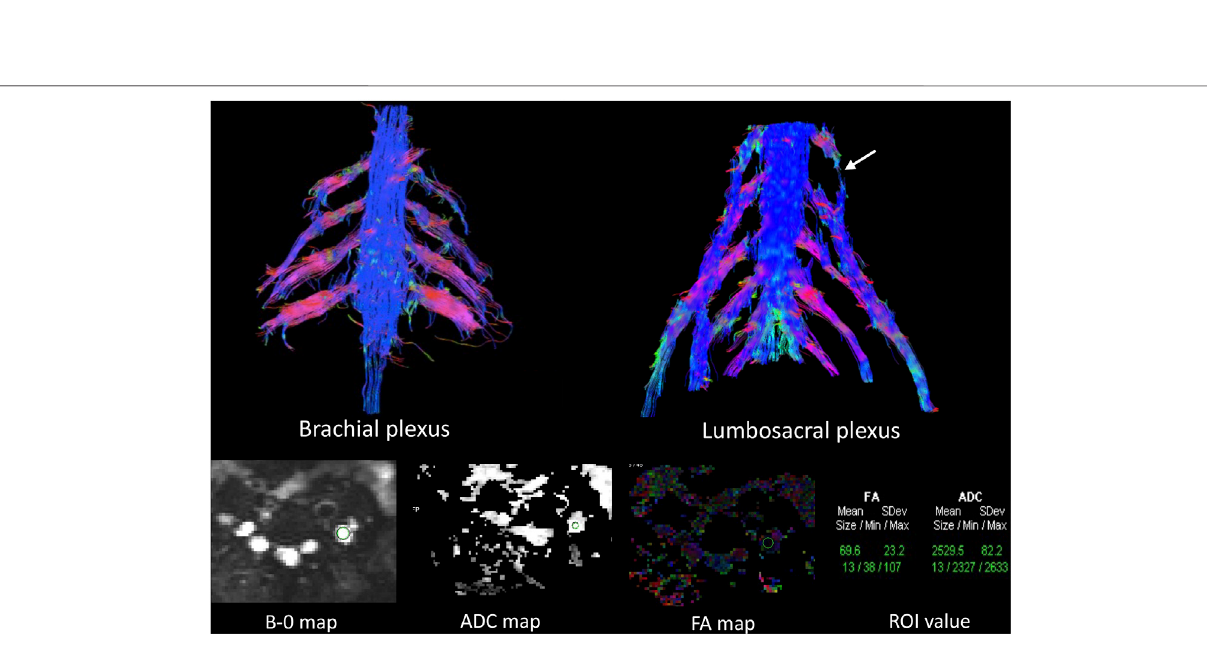
Frontiers in Genetics |